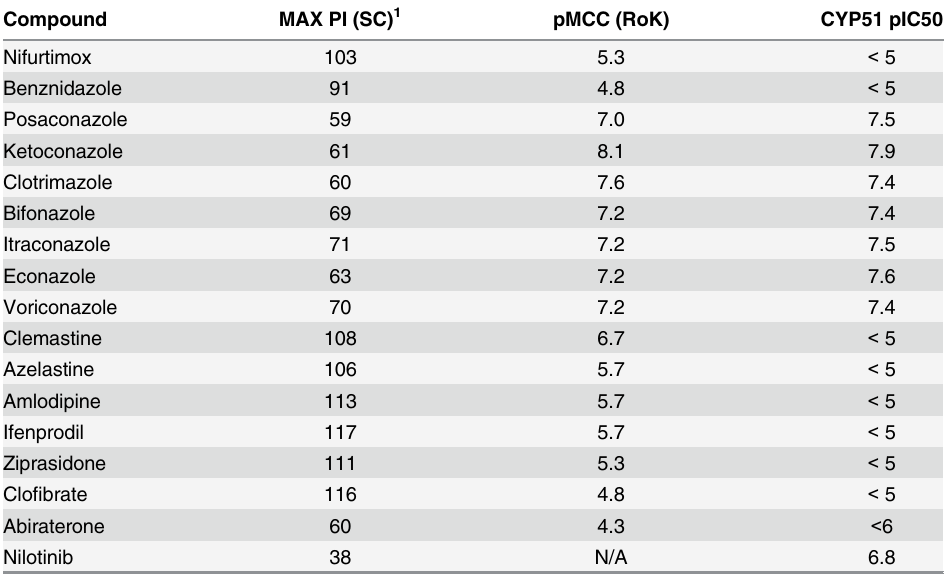
Table 3. Static-cidal (SC), Rate-of-kill (RoK) and CYP51 results for control compounds and selected hits from the bio-actives screen.